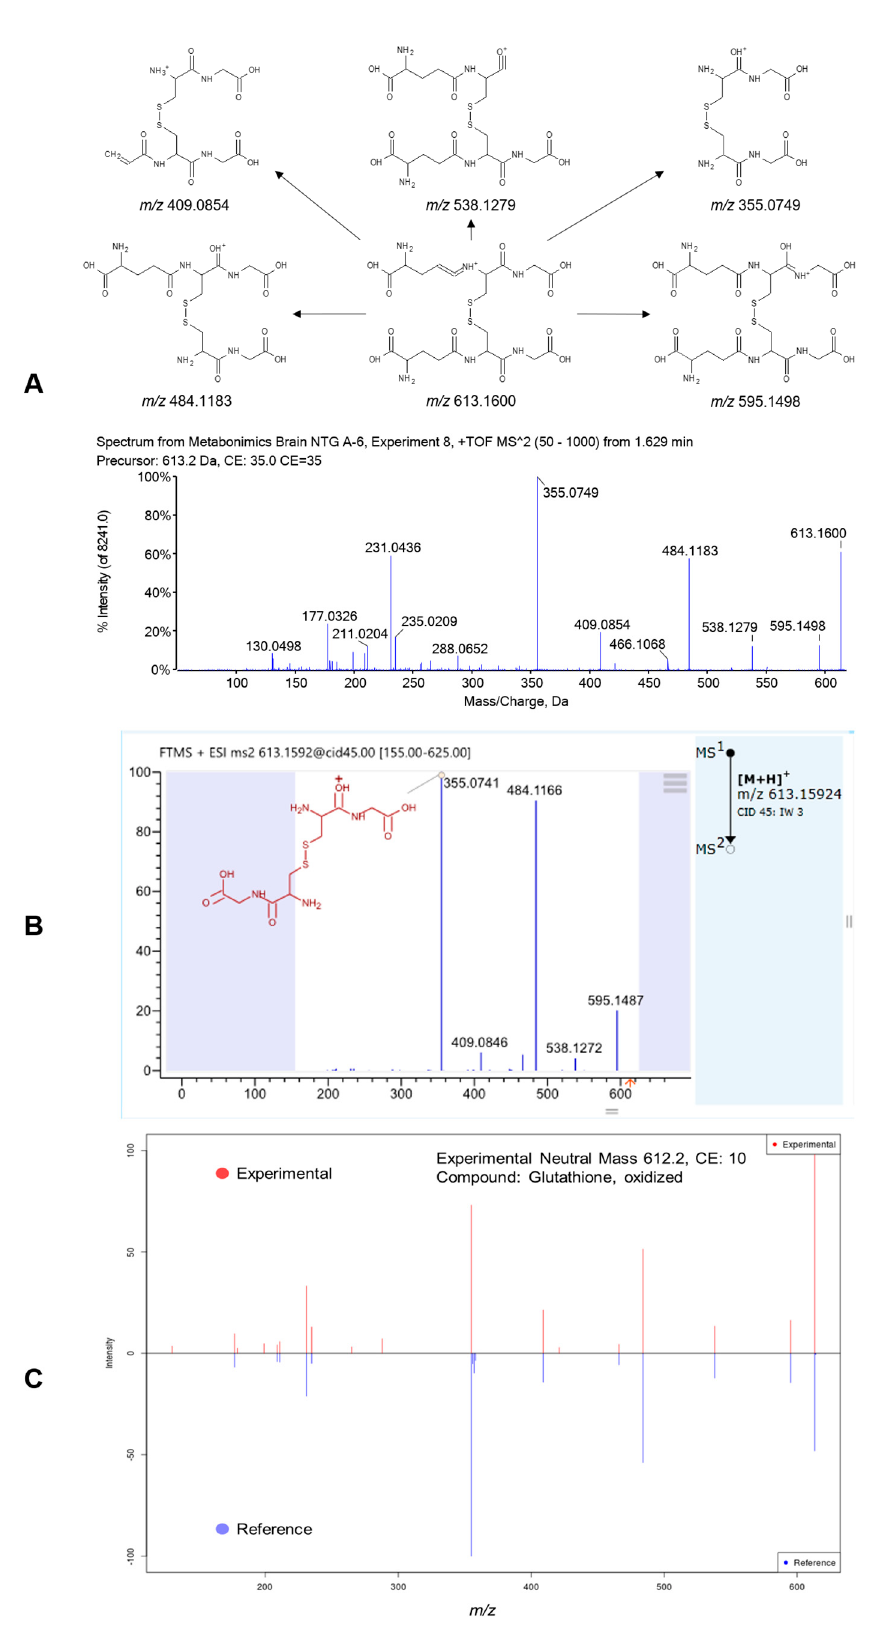
Figure 2. ( A ) Fragmentation pathway and product ion spectrum of oxidized glutathione; ( B ) MS/MS spectrum of oxidized glutathione by mzCloud and ( C ) the comparison spectrum between the experimental and reference MS/MS spectrum by METLIN.